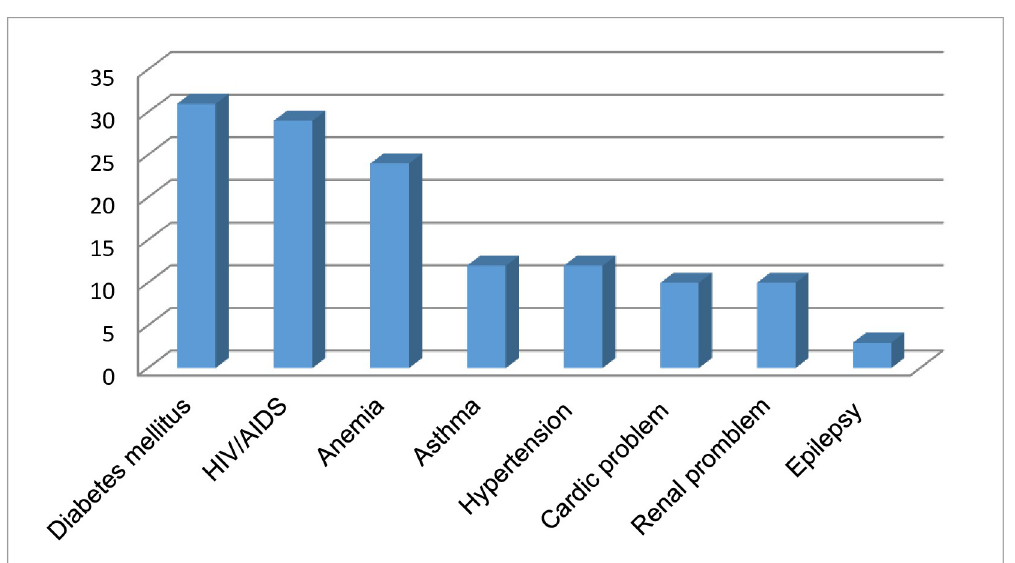
Fig 3. Types of pre-existing chronic illness among reproductive age women in Miza Aman town, Bench-Sheko Zone, Southwest Ethiopia, 2020 (n =